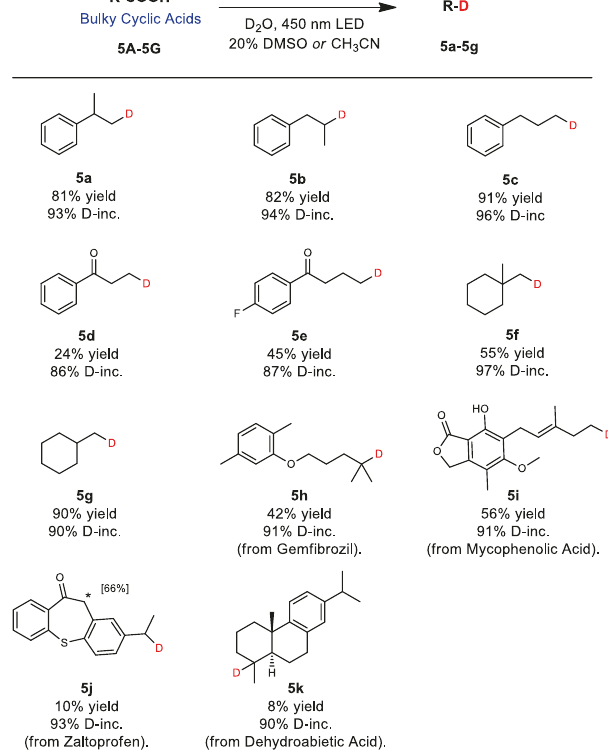
Fig. 6 Deuteration scope: bulky cyclic acids. Reaction conditions: Substrate (0.40 mmol), crude enzyme powder (containing Cv FAP about 20 mg), D 2 O (4 mL), DMSO or CH 3 CN (1 mL), 450 nm LED, 20 °C, 12 h. Yields were determined by GC. D-inc. data were determined by 1 H NMR or HRMS. *Non-enzymatic D-incorporation at C11 of 5j was also detected (see Supplementary Fig. 87).